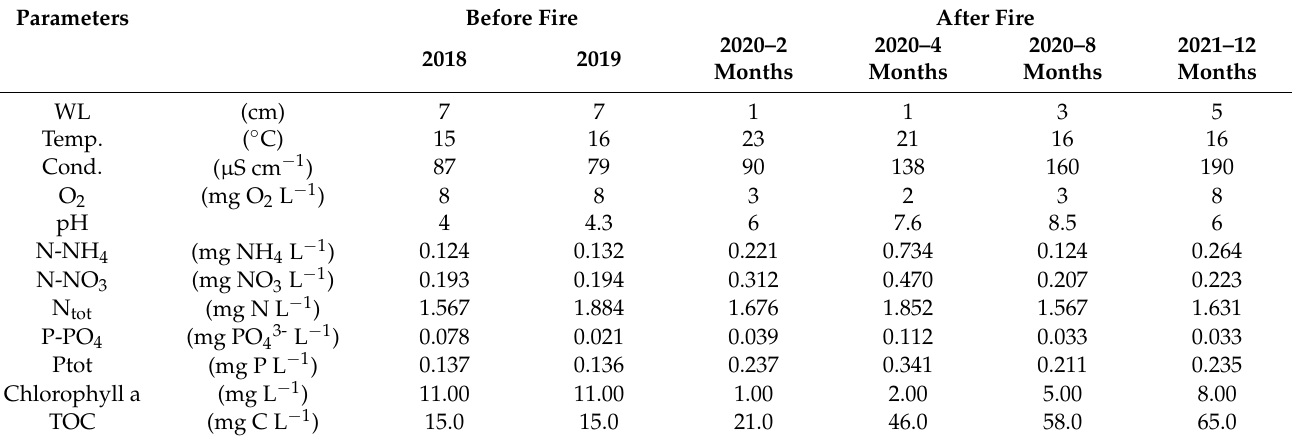
Table 1. Changes in physical and chemical parameters. Key: Water level (WL), temperature (Temp.), conductivity (Cond.), reaction (pH), dissolved oxygen (O 2 ), total phosphorus (Ptot), phosphates (P-PO 4 3 − ), total nitrogen (N tot ), ammonia nitrogen (N-NH 4 ), nitrite nitrogen (N-NO 3 − ), and total organic carbon